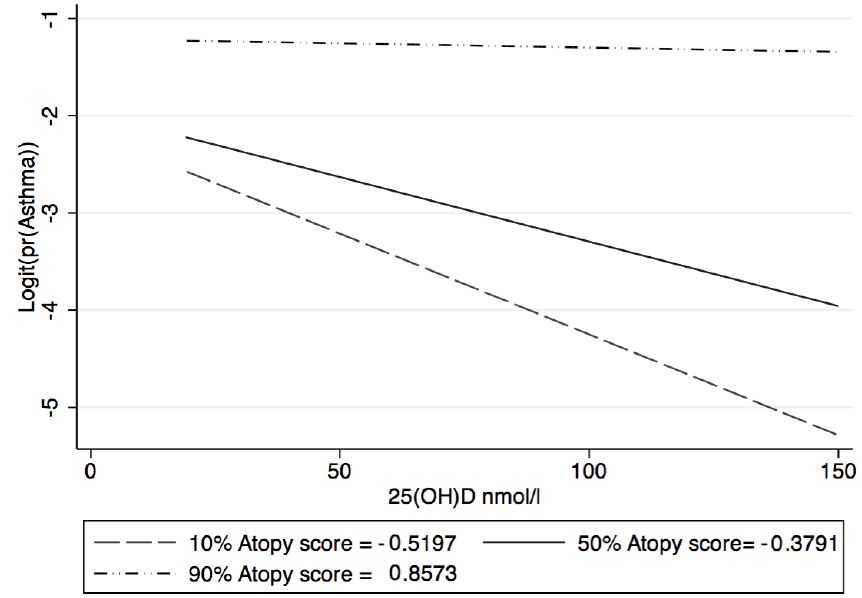
Figure 2. Association between 25(OH)D and asthma by atopy centile.